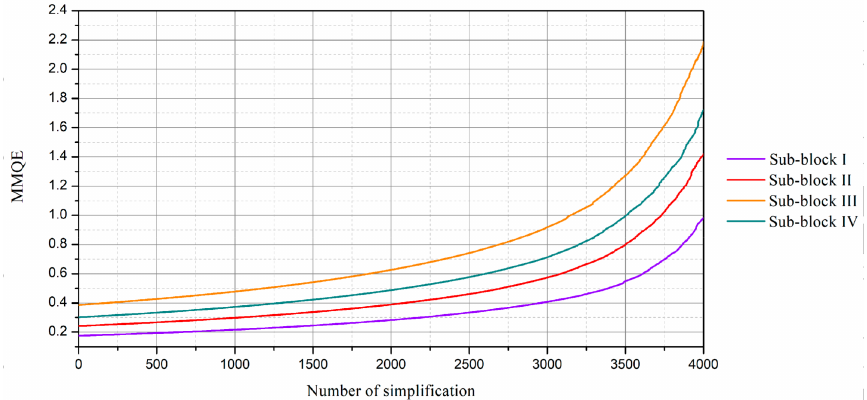
Figure 3. Variations of the MMQE, calculated by the points in each